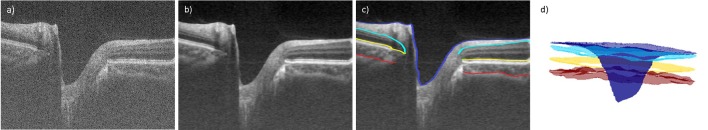
Example OCT B-scan (a) without processing, (b) after BV smoothing, and (c) with the segmentation of inner limiting membrane (purple), posterior boundary of retinal nerve fiber layer (cyan), Bruch's membrane (yellow), Bruch's membrane opening (green), and choroid-sclera boundary (red). 3D surface generation of the retinal layer boundaries is shown in (d).